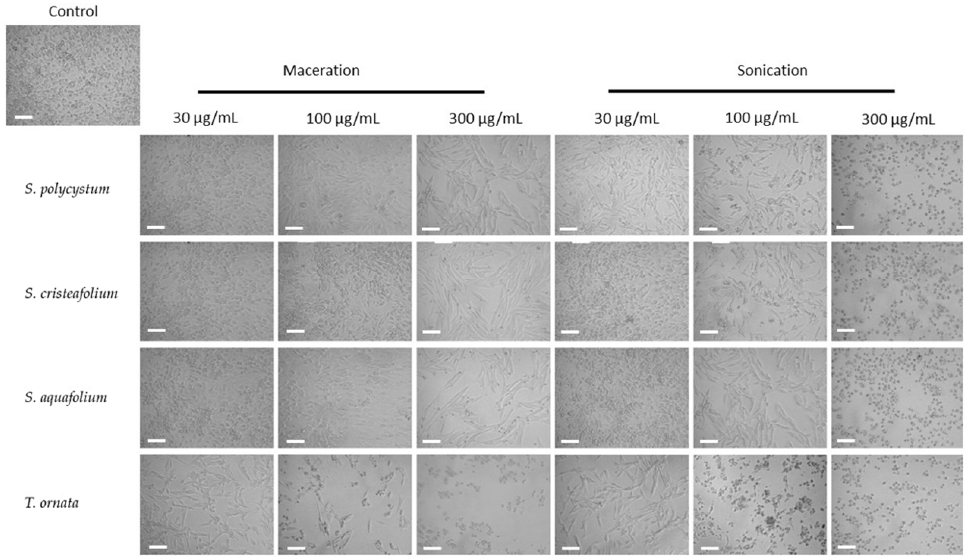
Figure 4. B16-F10 melanoma cell morphology and growth after treatment for 48 h with ultrasonic- assisted extraction (UAE/sonication) and cold maceration extracts of Sargassum polycystum , Sargas- sum cristaefolium , Sargassum aquifolium and Turbinaria ornata at different concentrations (30 μ g/mL, 100 μ g/mL, and 200 μ g/mL); (Scale bar = 100 μ M).